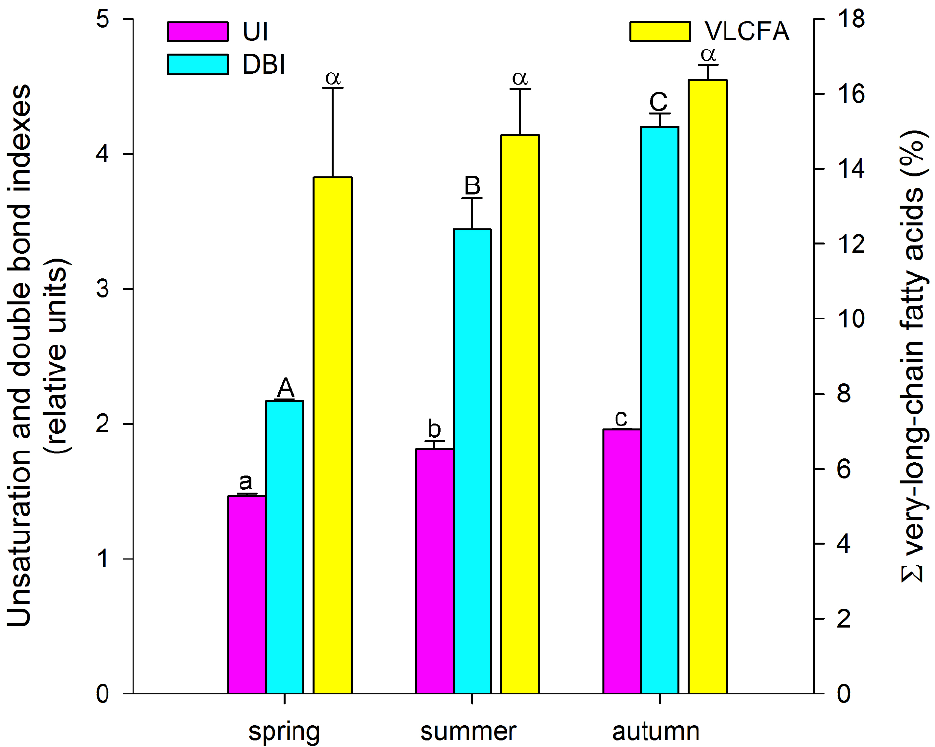
Figure 2. Unsaturation index (UI) and double-bond index (DBI), as well as the total amount of very-long-chain fatty acids ( Σ VLCFAs) in Asplenium scolopendrium fronds in spring, summer, and autumn. Values are presented as the means ± SEMs. Different letters indicate a significant difference between the means ( p ≤ 0.05). One-way ANOVA, followed by Tukey’s HSD test, was performed separately for each parameter.